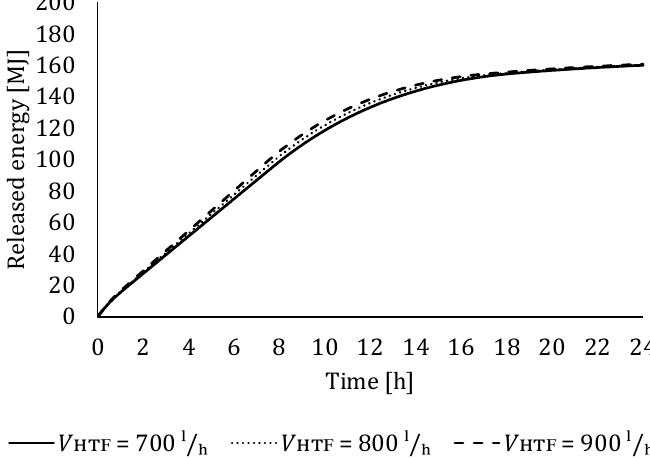
Figure 23. Comparison of released energy during solidification obtained numerically for different HTF flow rates, HTF inlet temperature 10 °C and initial PCM temperature 35 °C.